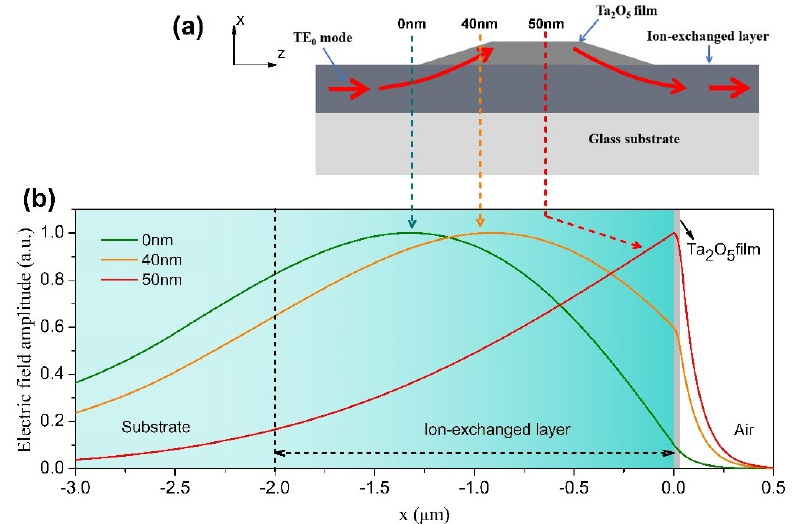
Figure 2. Simulation of the local TE 0 modes in the COWG: ( a ) schematic diagram of the COWG with a tapered layer of Ta 2 O 5 (the arrowed lines show the mode propagation path); ( b ) simulated field profiles of the local TE 0 modes at different positions of the